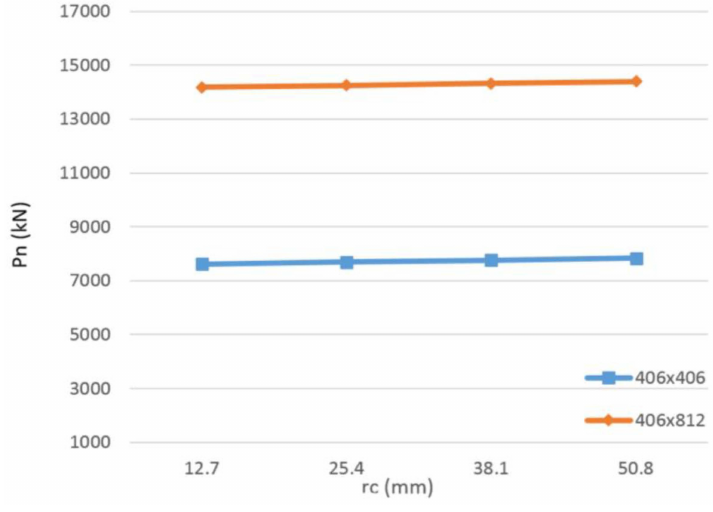
Figure 24. Axial capacity variation for sections of 406 ˆ 406 mm and 406 ˆ 812